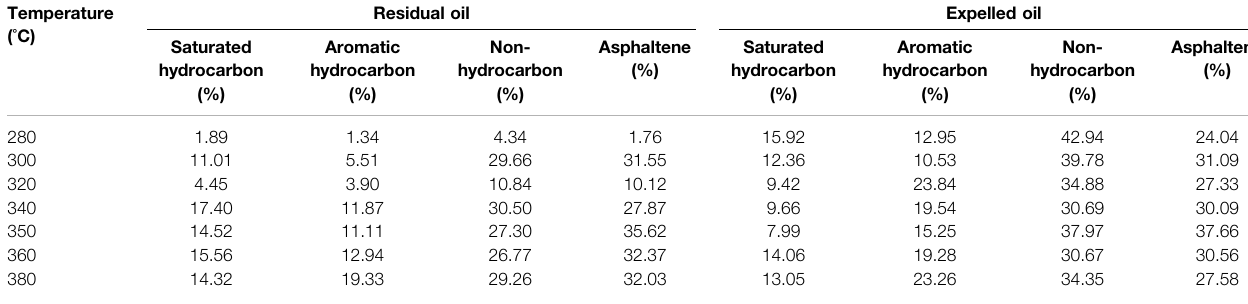
TABLE 5 | Analysis of group compositions of oil generated from stromatolite Temperature ( °